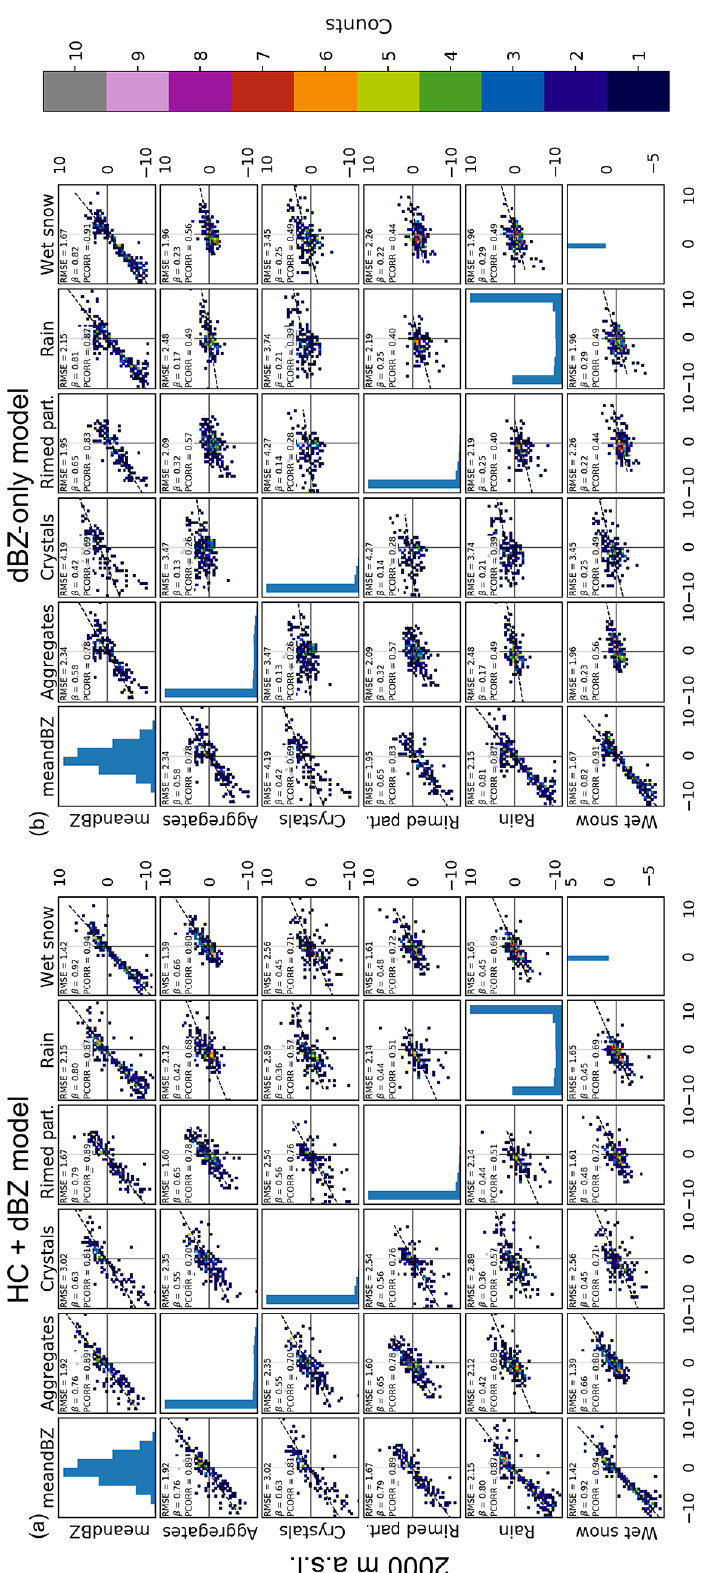
Figure 11. The 2-D histograms for observed ( x axes) and predicted ( y axes) GD for the HC + dBZ model (a) and dBZ-only model (b) trained from 2000ma.s.l. (bottom row) and data aloft. The number of points in each bin is indicated in